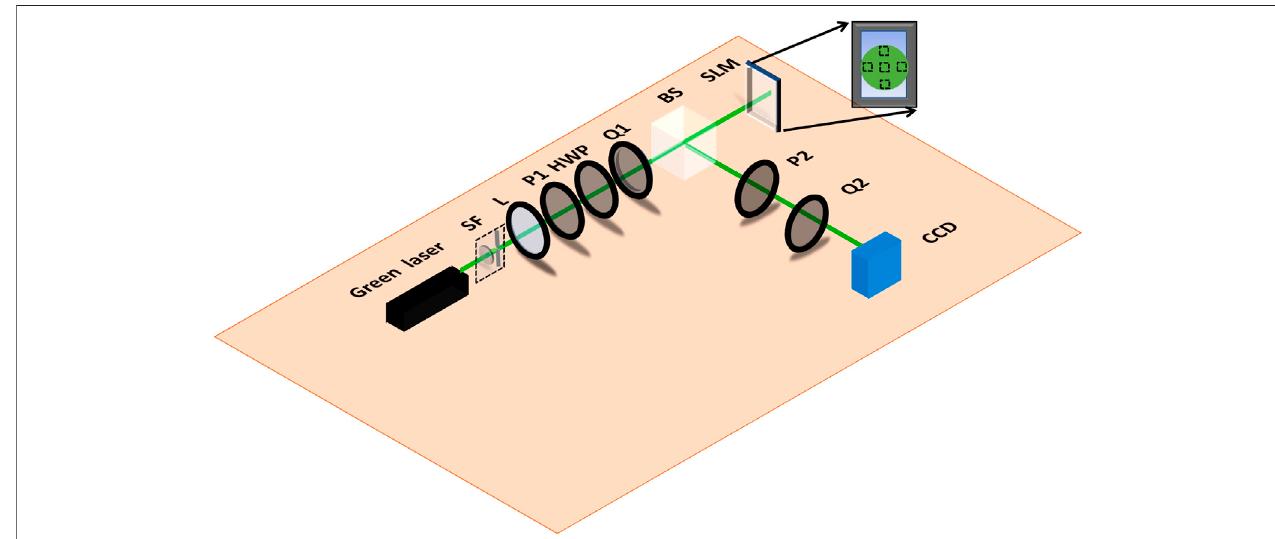
FIGURE1| SchematicofMuellermatriximagingpolarimeter(MMIP)forMuellermatriximagingofSLM.[SF:spatial fi lter,L:lens,P:polarizer,HWP:half-waveplate, Q: quarter-wave plate, BS: beam splitter, SLM: spatial light modulator, CCD: charged coupled device (camera)]. Figure insight represents the selection of spatial locations of SLM display.